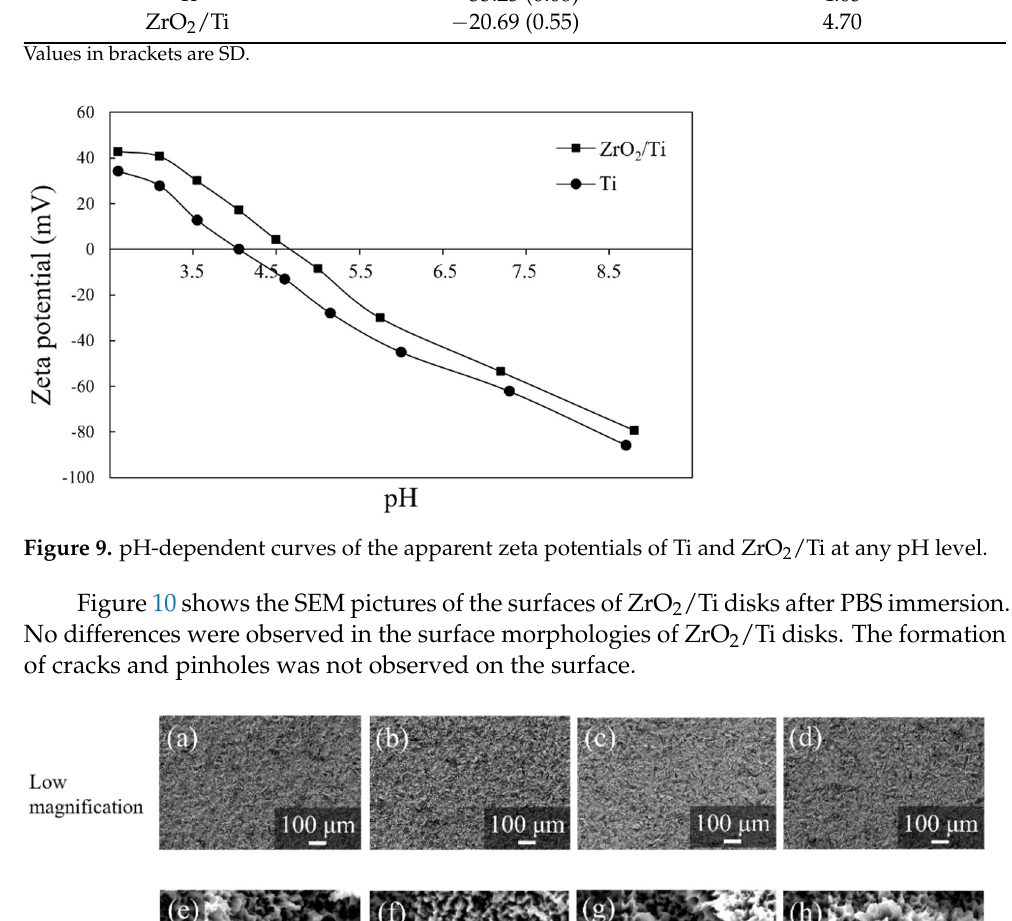
Figure 10. SEM profiles of the surfaces of ZrO 2 /Ti disks after PBS immersion. ( a , e ) 7, ( b , f ) 14, ( c , g ) 30, and ( d , h ) 90 days after immersion. (Magnification of ×100 and ×5000).